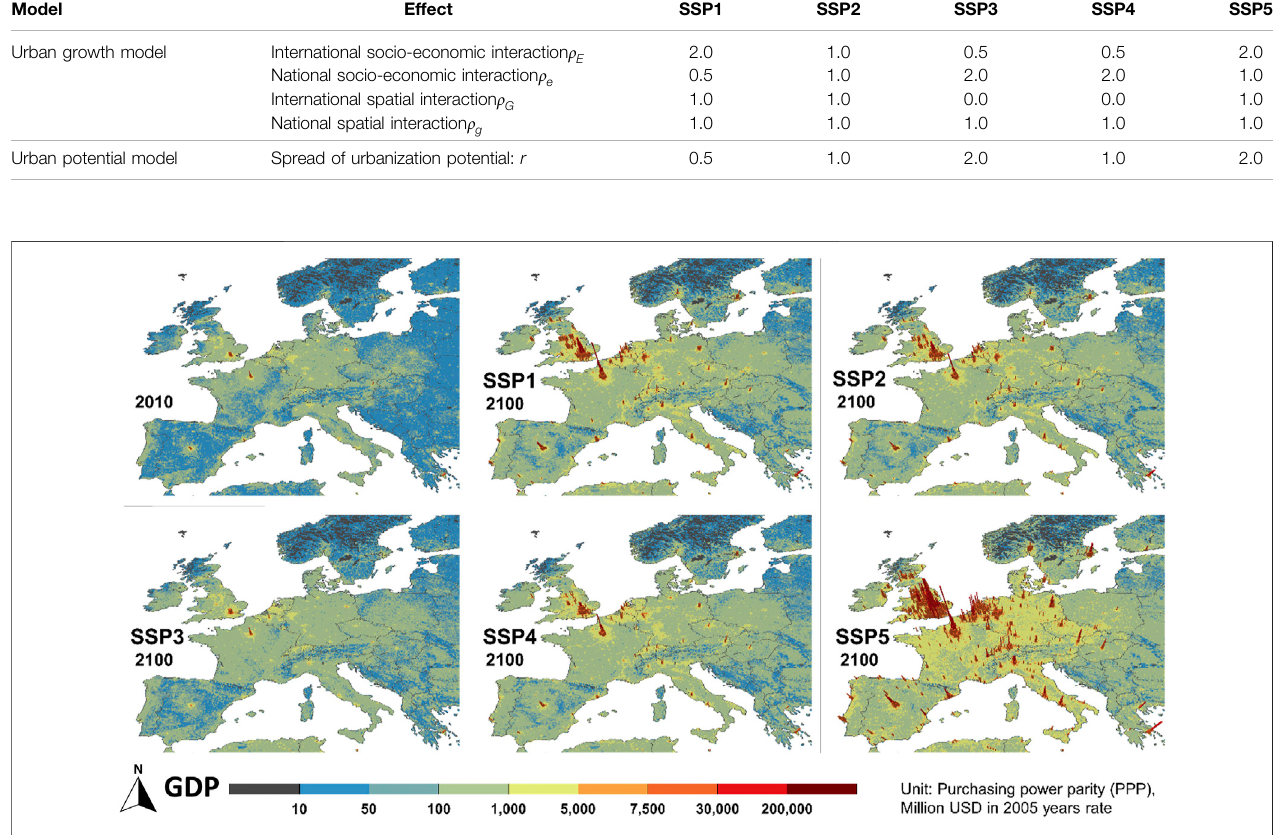
Frontiers in Built Environment |